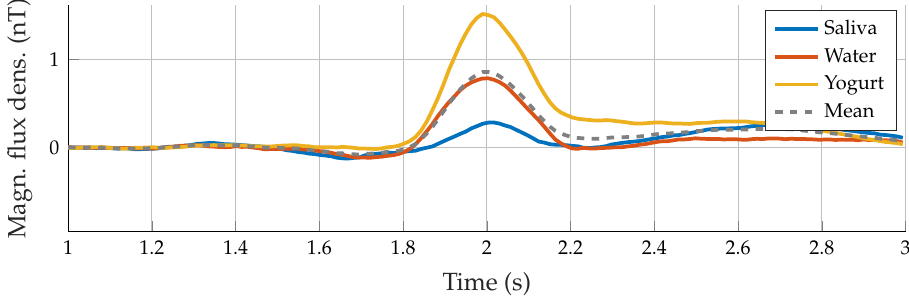
Figure 5. Example of the average signals for each swallowing task of Subject “b”.